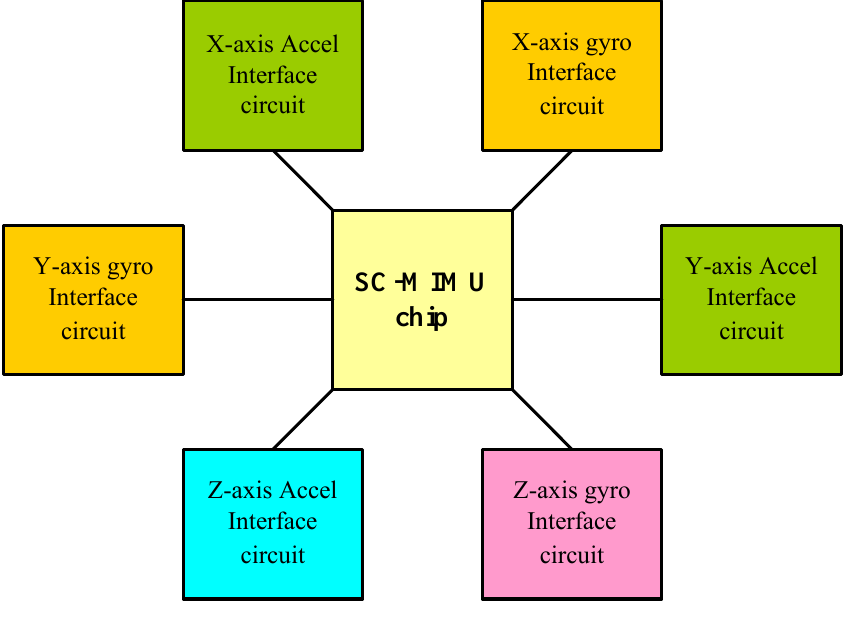
Figure 12. Layout configuration of the interface circuit chip in